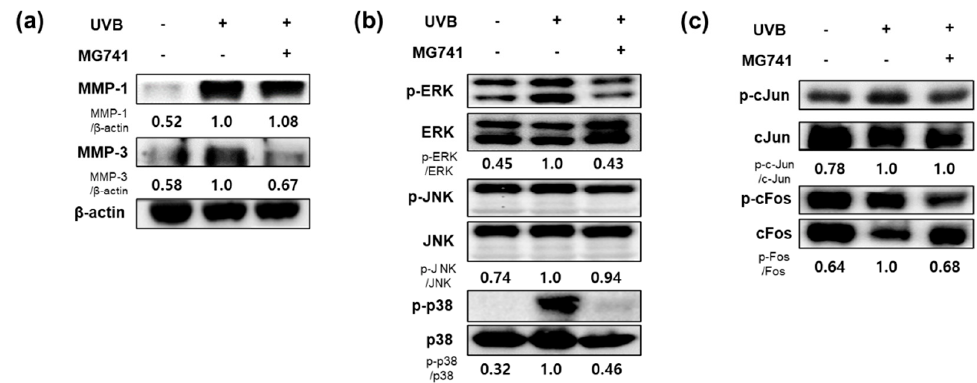
Figure 6. The protein expressions of wrinkle-related factors in Bi. lactis MG741 administration with UVB-exposed dorsal skin tissue of HR-1 mice. The animal experiment procedure is the same as described in the legend in Figure 4. ( a ) MMPs, ( b ) MAPKs, and ( c ) activator protein 1 (AP-1) expressions of mouse dorsal skin were analyzed by Western blotting. The ratio of each protein was shown below the blotting images and indicated to fold of UVB-exposed control. Data are indicated as means ± SE ( n = 6).